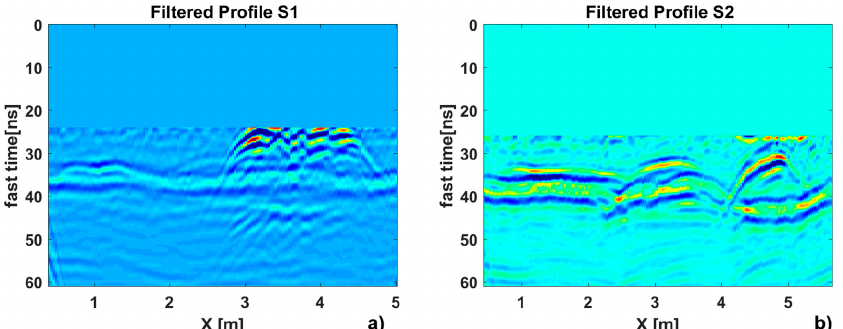
Figure 10. Filtered radargram obtained by means of pre-processing procedure associated to the profile S1 ( a ) and S2 ( b ).